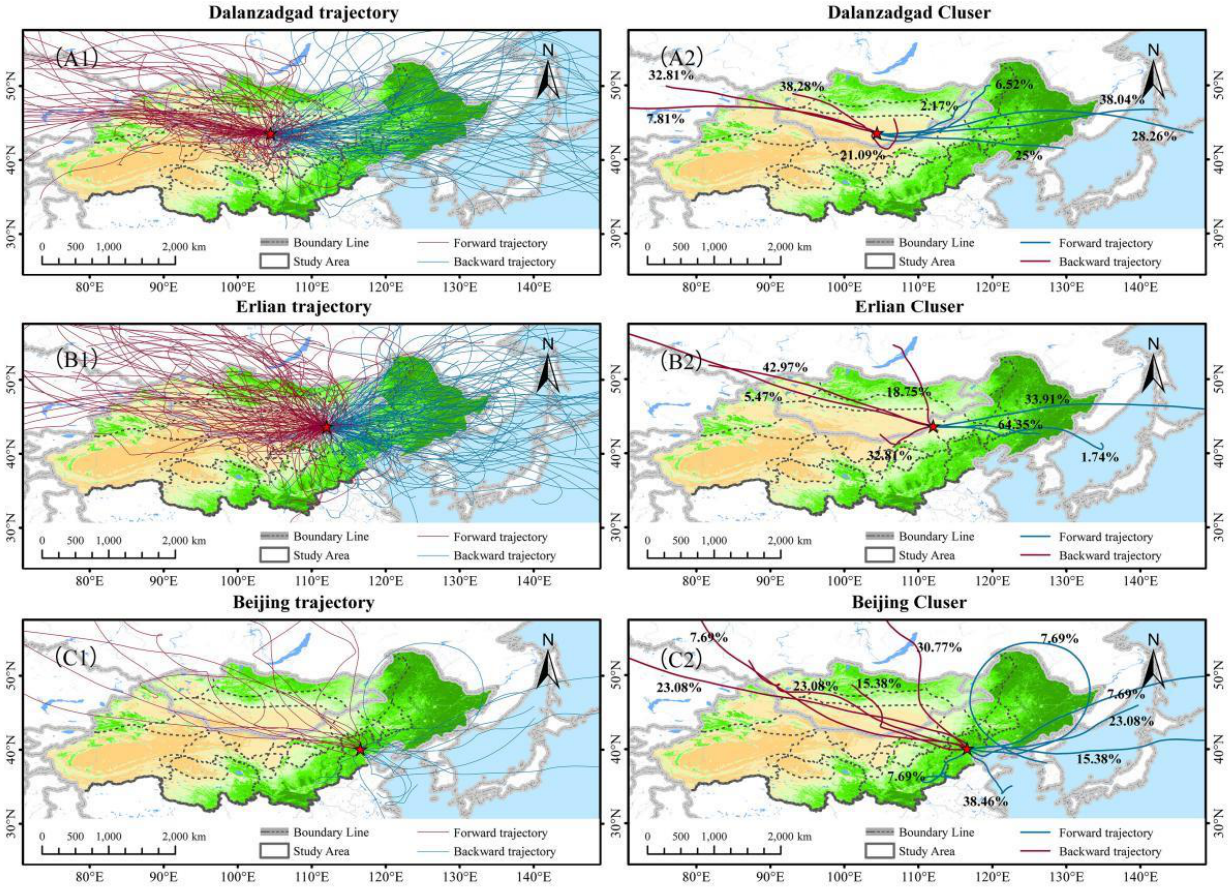
Figure 8. 72 h of forward and backward trajectory ( A1 , B1 , C1 ) and trajectories clustering ( A2 , B2 , C2 ) of dusty weather. Blue lines indicate the airflow forward trajectory, and red lines indicate the airflow backward trajectory.